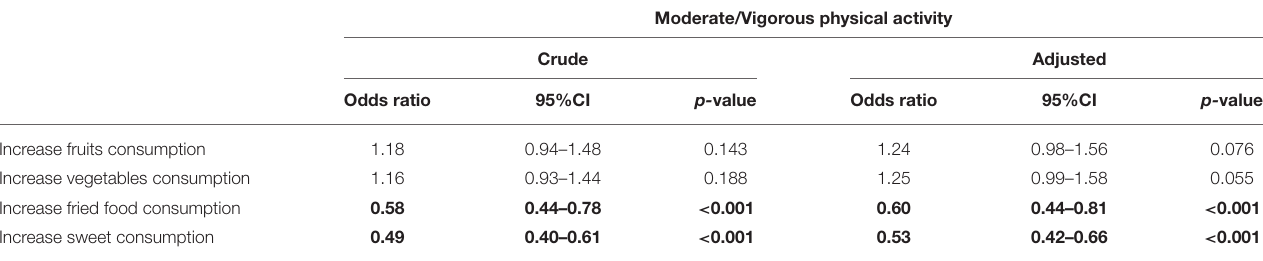
TABLE 2 | Association between physical activity ( ≥ 150 min in MVPA) and change in food habits during COVID-19 social isolation in Brazilians, n = 1,874.